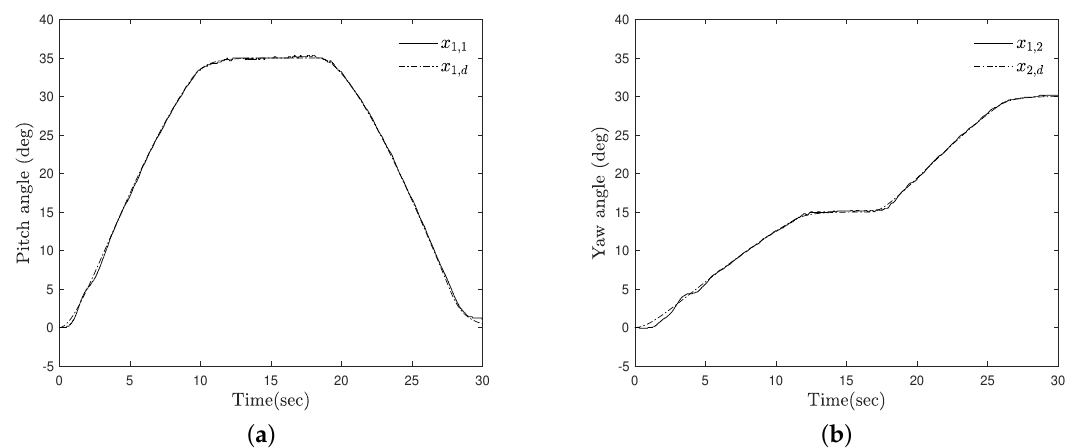
Figure 7. Tracking results for experiment ( a ) x 1,1 and x 1, d ( b ) x 1,2 and x 2, d .